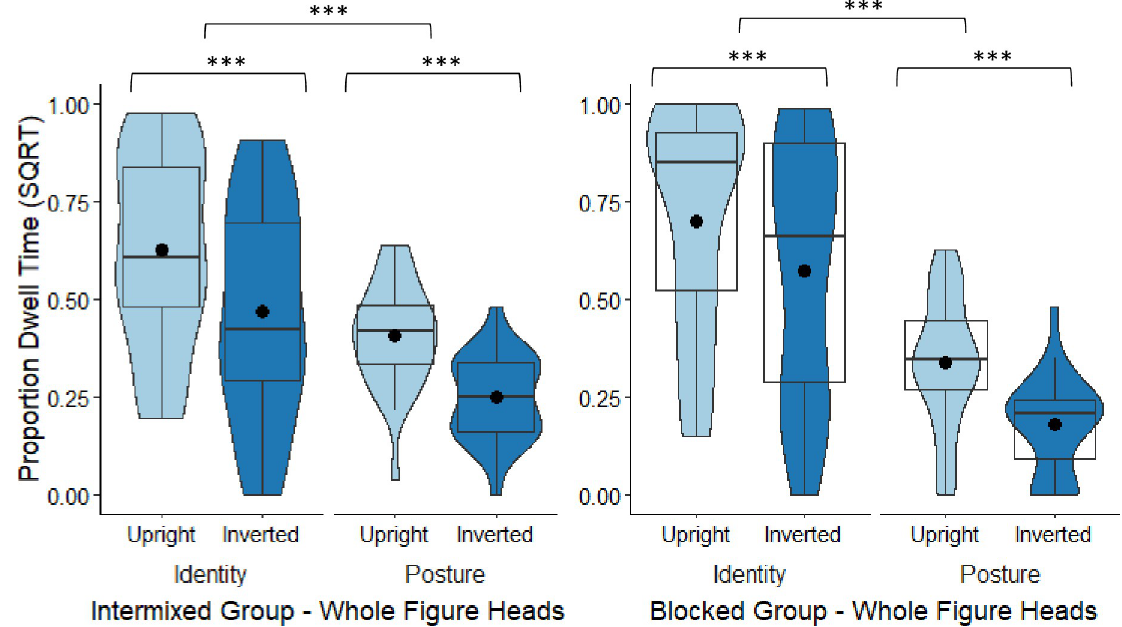
Fig 6. Intermixed and blocked groups’ box and violin plots of dwell time (DT) proportions (square-root transformed) to the heads in the whole figure upright and whole figure inverted conditions in the identity and posture tasks; dots denote means; ��� = p < .001.